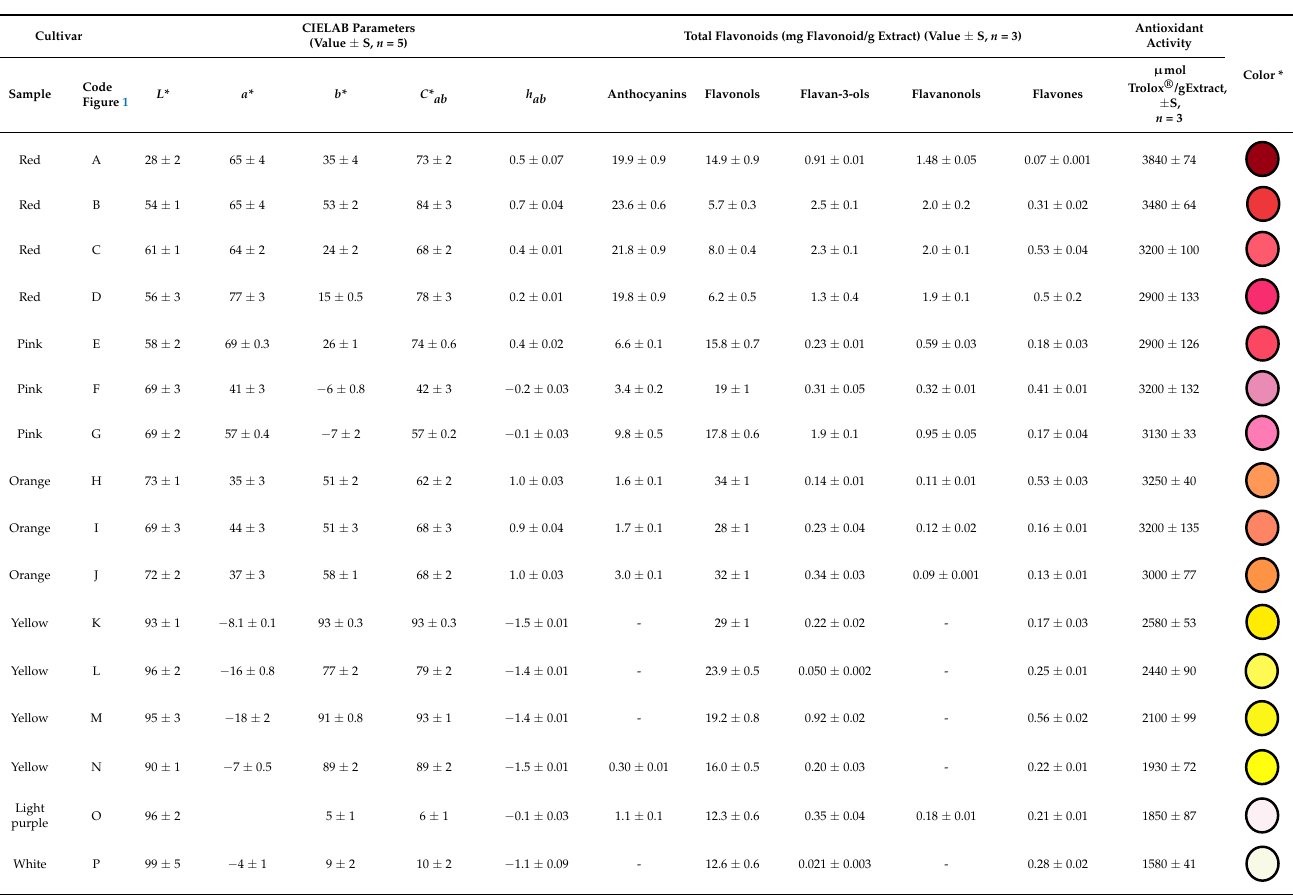
Table 2. Total flavonoids, organized by subfamilies, and CIELAB colorimetric parameters measured for different H. rosa ‐ sinensis cultivars studied.